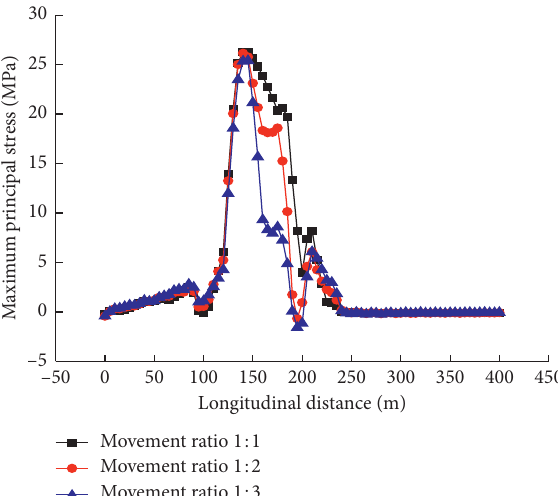
Figure 8: Maximum principal stress distribution curve of the lining with different movement ratios under the coupling fault.